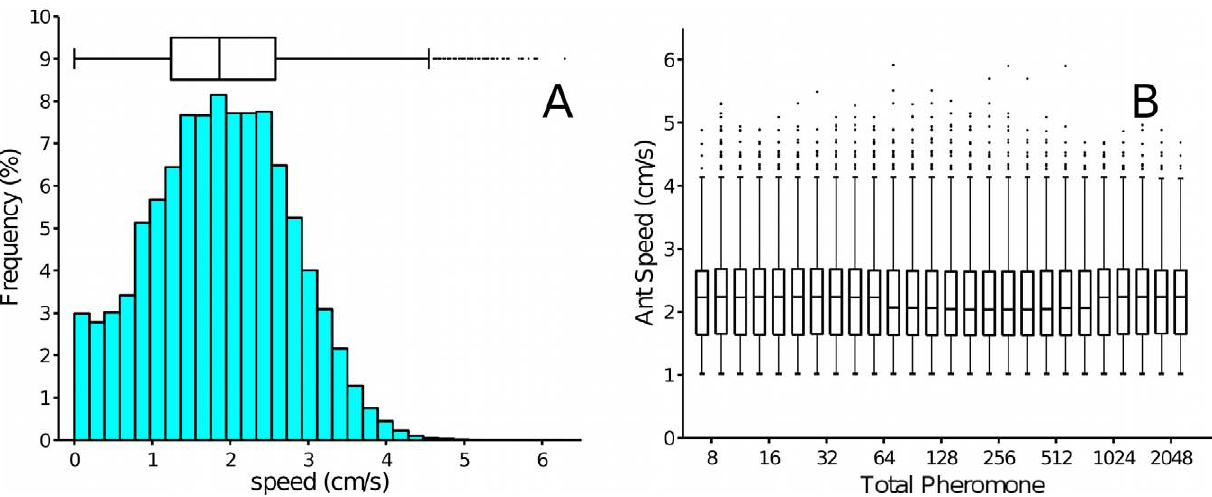
Figure 3. Speed distribution for individual ants (plot A) and distribution of speed as a function of the total pheromone encountered ( L z R ) (plot B). The graph in A is from all data, while the one in B is limited to ‘‘moving’’ ants (ants that move at least 0.4 cm in each of the two time intervals; see methods) because of the difficulty in defining regions L and R for ants that do not move. The speed measured in both graphs is the average speed over 0.4 second intervals. The median and other percentiles are affected by small quantization effects, because ant position is recorded in pixel coordinates ( 1pixel * 0 : 8mm , with small differences in different trials). The sample sizes of the boxplots in B are different. The whiskers in all the boxes represent data within 1 : 5 IQR of the quartiles; circles represent outlier data points.